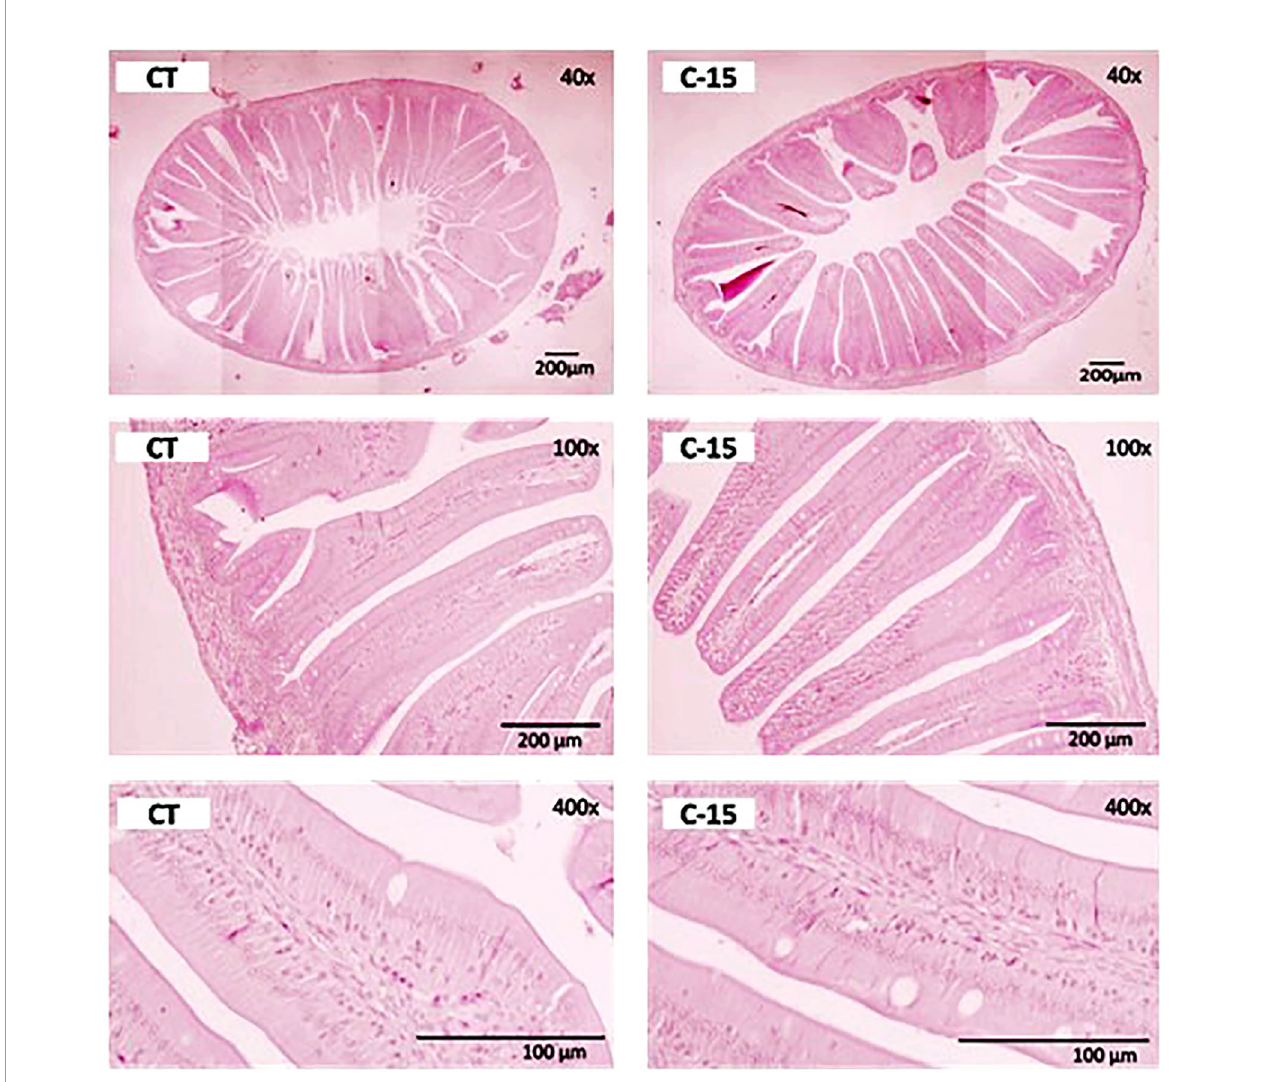
FIGURE 2 | Transversal sections from the proximal intestine of C. labrosus juveniles fed control (CT) or experimental (C-15) diets during 90 days. H&E stain, scale bar 200 m m, and 100 m m. Dietary codes: CT, control diet; C-15, 15% C. fusca supplemented-diet.